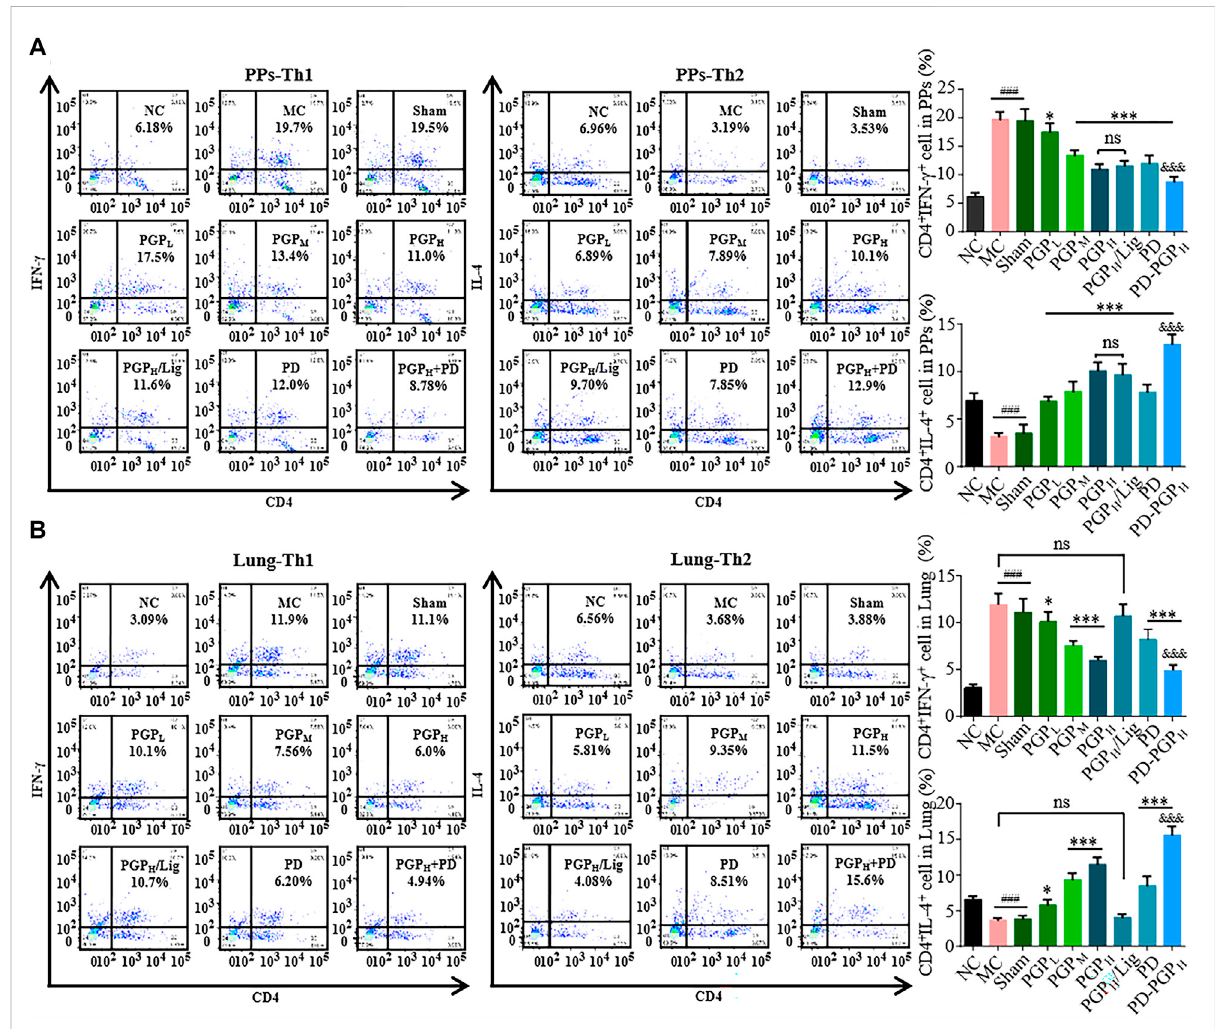
FIGURE 3 Flowcytometryscatterplots(A1andB1)anddataanalysischarts(A2andB2)ofTh1(CD4 + IFN- γ + )andTh2(CD4 + IL-4 + )proportionsinPPs (A) and lung tissues (B) of CB rats, after 90 min intestinal perfusion of PGP (groups PGP L/M/H ), PD (group PD), and PD-PGP (groups PD-PGP H ), with (group PGP H /Lig) or without mesenteric lymphatic vessel ligation. Th1 and Th2 proportions in PPs and lung tissues from normal (groups NC), model (group MC), and sham-operated (group Sham) rats were set as the comparison. (Data are expressed as mean ± SD ( n = 6); * p < 0.05 and *** p